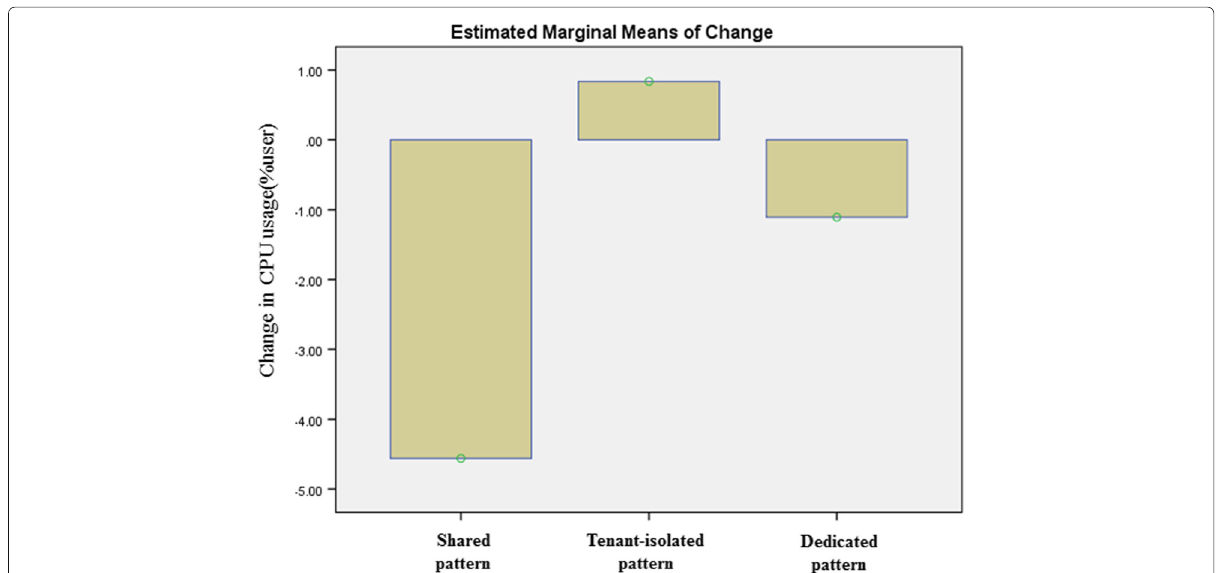
Fig. 11 Changes in CPU [CS1]